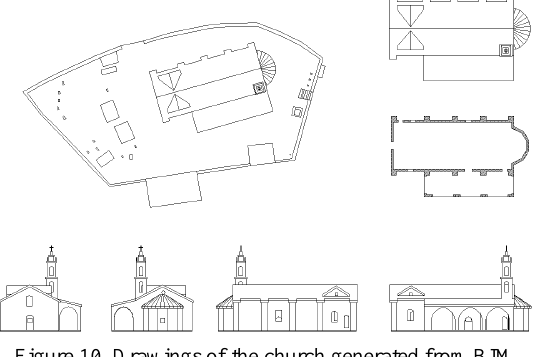
Figure 10. Drawings of the church generated from BIM